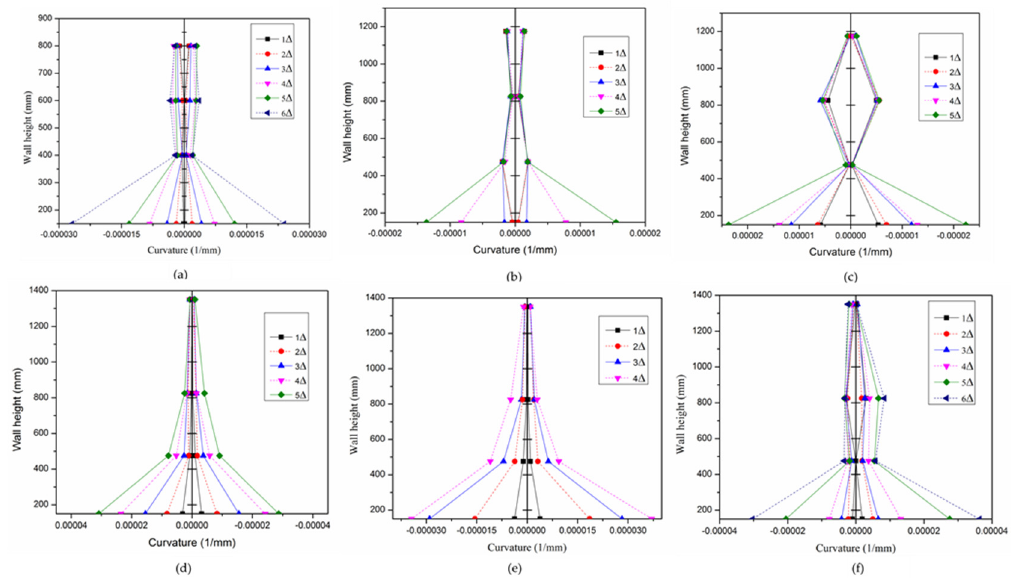
Figure 10. Curvature profile along the wall height of the SCMSW specimens: ( a ) SW1; ( b ) SW2; ( c ) SW3;